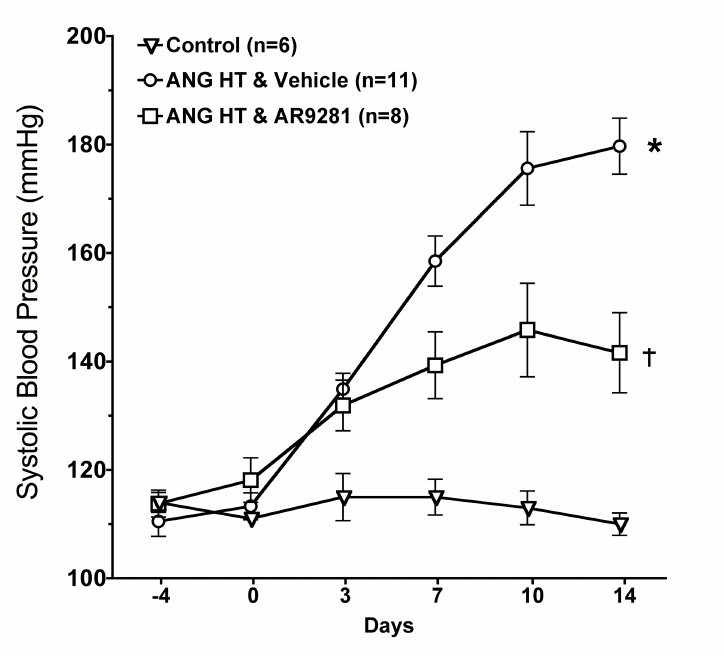
Figure 1. The effect of the sEHI, AR9281 on systolic blood pressures in angiotensin- infused rats (ANG HT). Values are mean ± SEM. *Significant difference between control and ANG HT & vehicle groups, = significant difference between ANG HT and vehicle and ANG HT and AR9281